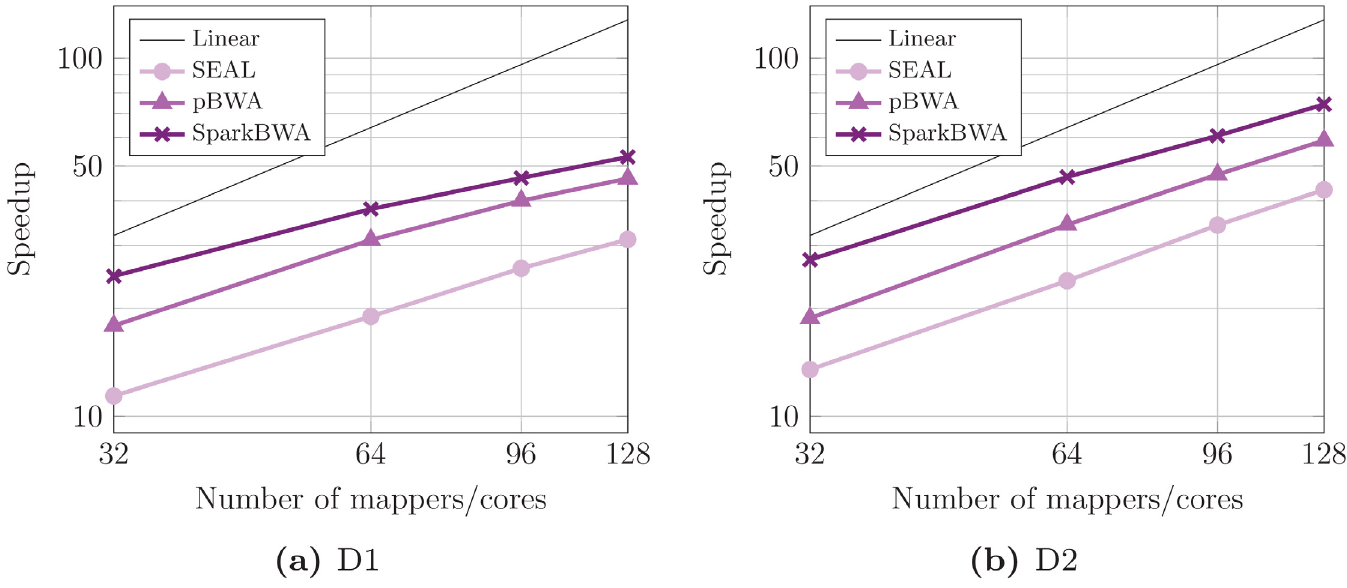
Fig 10. Speedup considering several BWA-based aligners running the BWA-backtrack algorithm (axes are in log